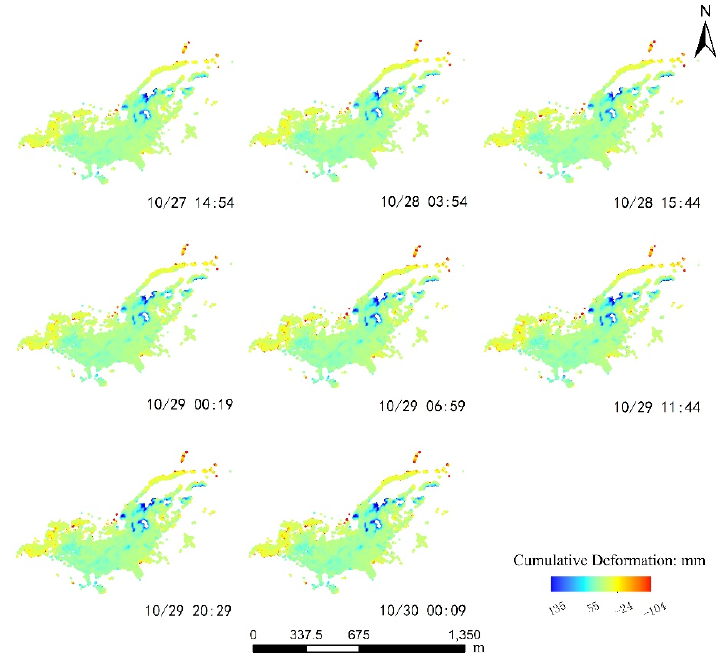
Figure 10. Historical results of deformation prediction along LOS direction. The displacement map was generated between the date that is marked in the low right corner and 17 October 2021 (the first acquisition date of GBSAR image). The deformation of the landslide is obvious. The color bar ranges from -104mm to 135mm.